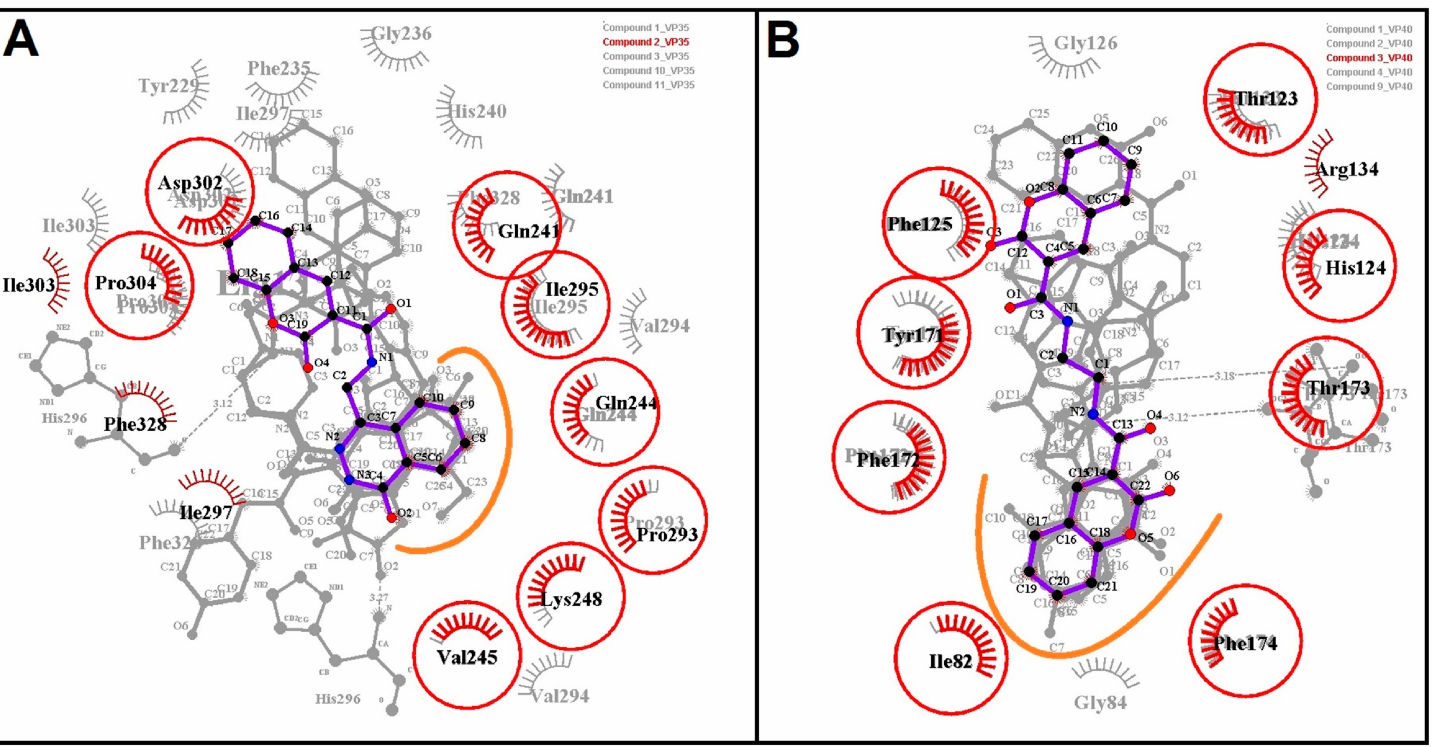
Figure 4. Protein ligand analysis by ligplot. Ligplots showed the conserved binding modes (outlined by the orange lines) of virtual hits with respective targets: EBOV-Z VP35 ( A ) and VP40 ( B ). Conserved interacting residues are displayed in red circles.